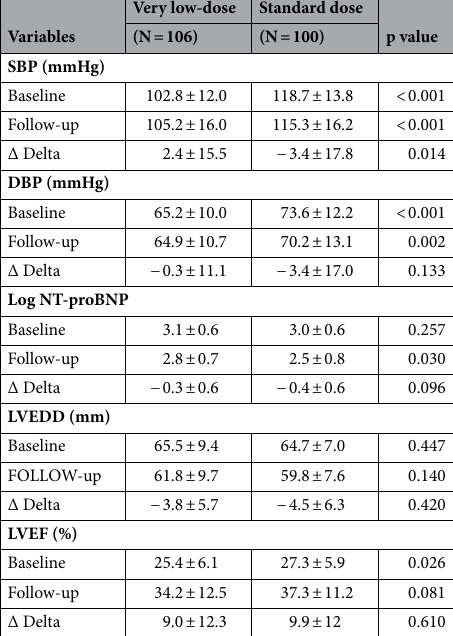
Table 2. Changes in laboratory and echocardiographic parameters after treatment with sacubitril/valsartan. SBP systolic blood pressure, DBP diastolic blood pressure, NT-proBNP N-terminal prohormone of brain natriuretic peptide, LVEDD left ventricular end diastolic diameter, LVEF left ventricular ejection fraction.